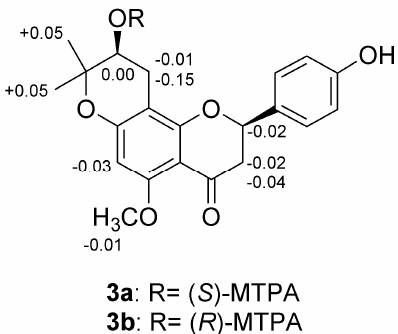
Figure 2. The ∆ δ S − R values (ppm) from Mosher ester derivatives of 3 Figure 2. The  S-R values (ppm) from Mosher ester derivatives of 3.